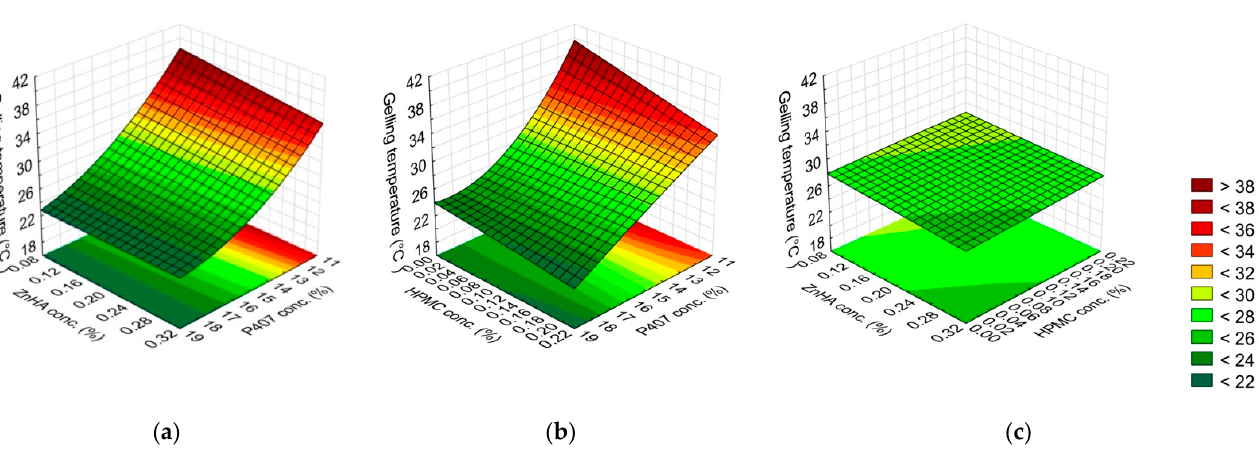
Figure 1. Effect of the composition on the gelling temperature: ( a ) P407 and ZnHA concentrations, ( b ) P407 and HPMC concentrations, ( c ) ZnHA and HPMC; (the 3rd factor is at 0 level in each case). Table 4. Results of the experiments (mean values) of the samples for the factorial design.